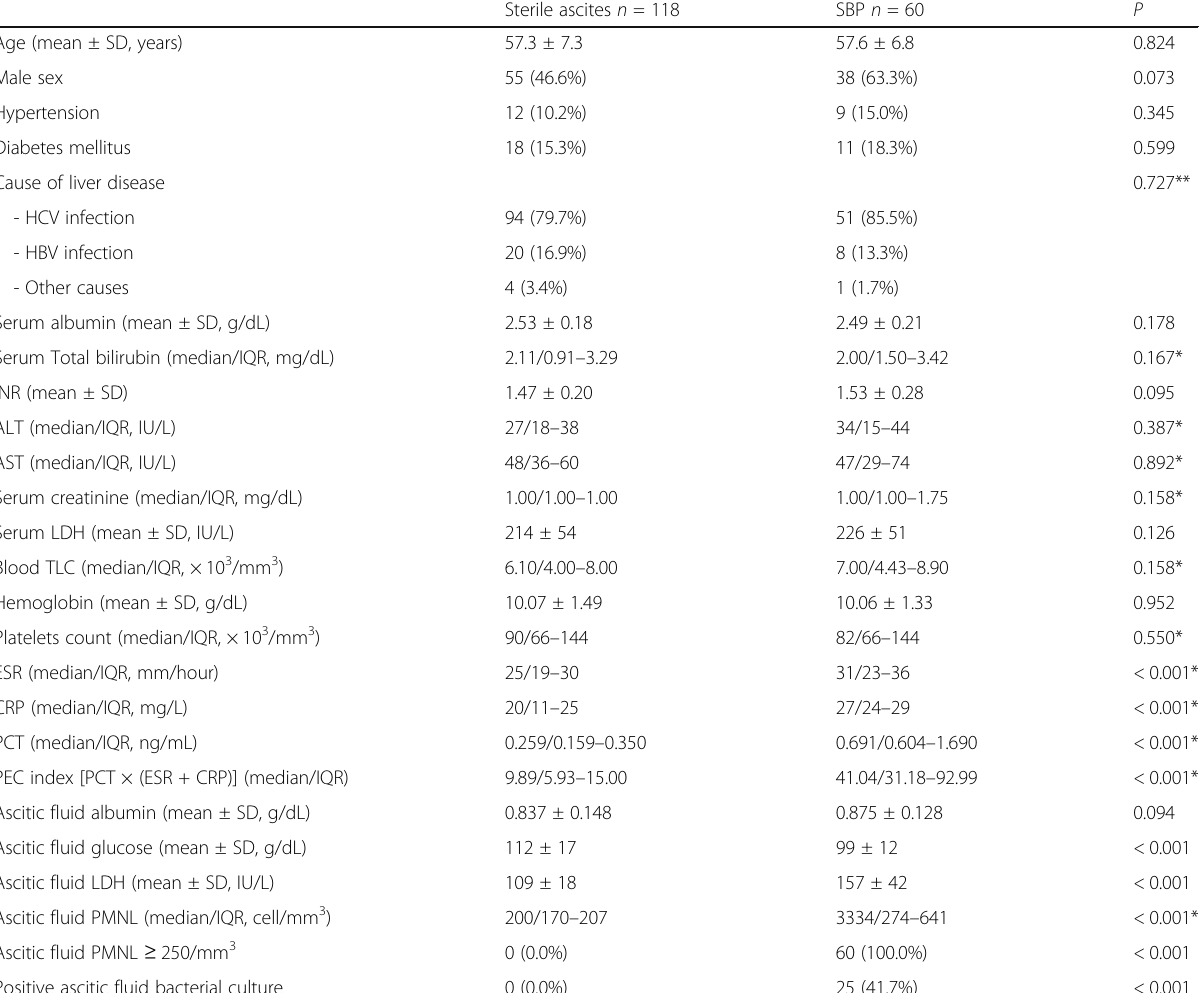
Table 1 Demographic, clinical, and laboratory data of the studied groups